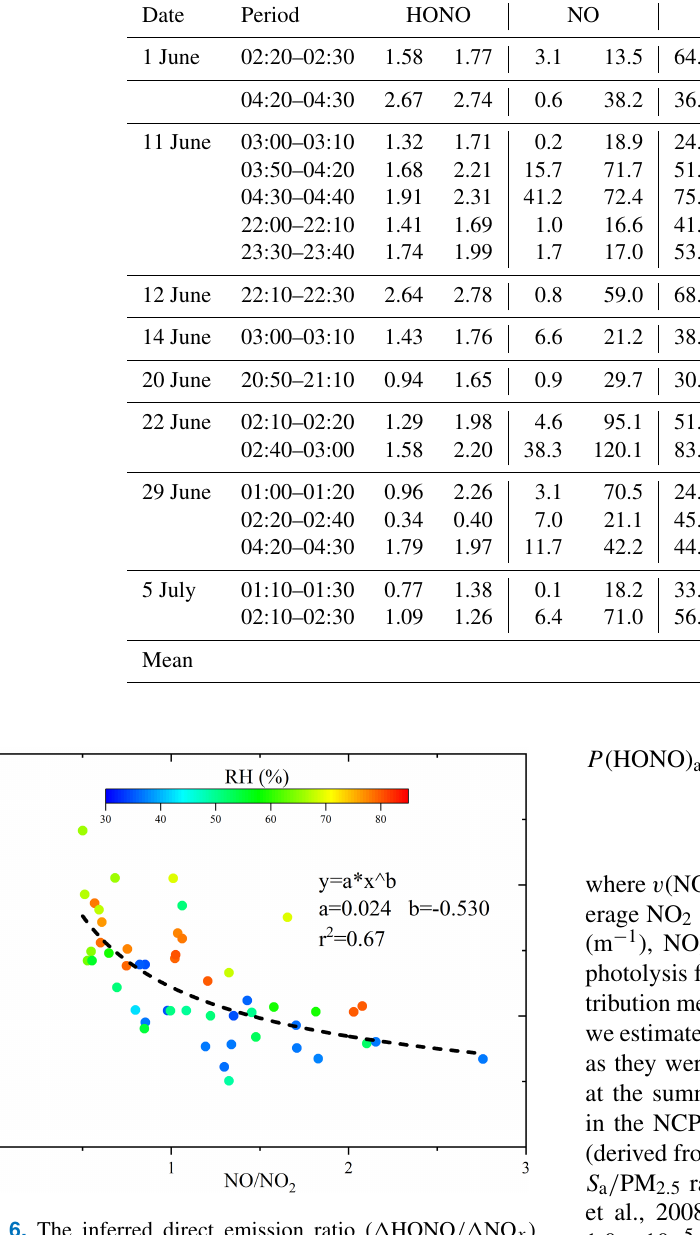
Figure 6. The inferred direct emission ratio ( (cid:49) HONO /(cid:49) NO x ) and NO / NO 2 colored by RH. Only data with NO / NO 2 > 0 . 5 were shown as lower ratios indicate more aged rather than fresh